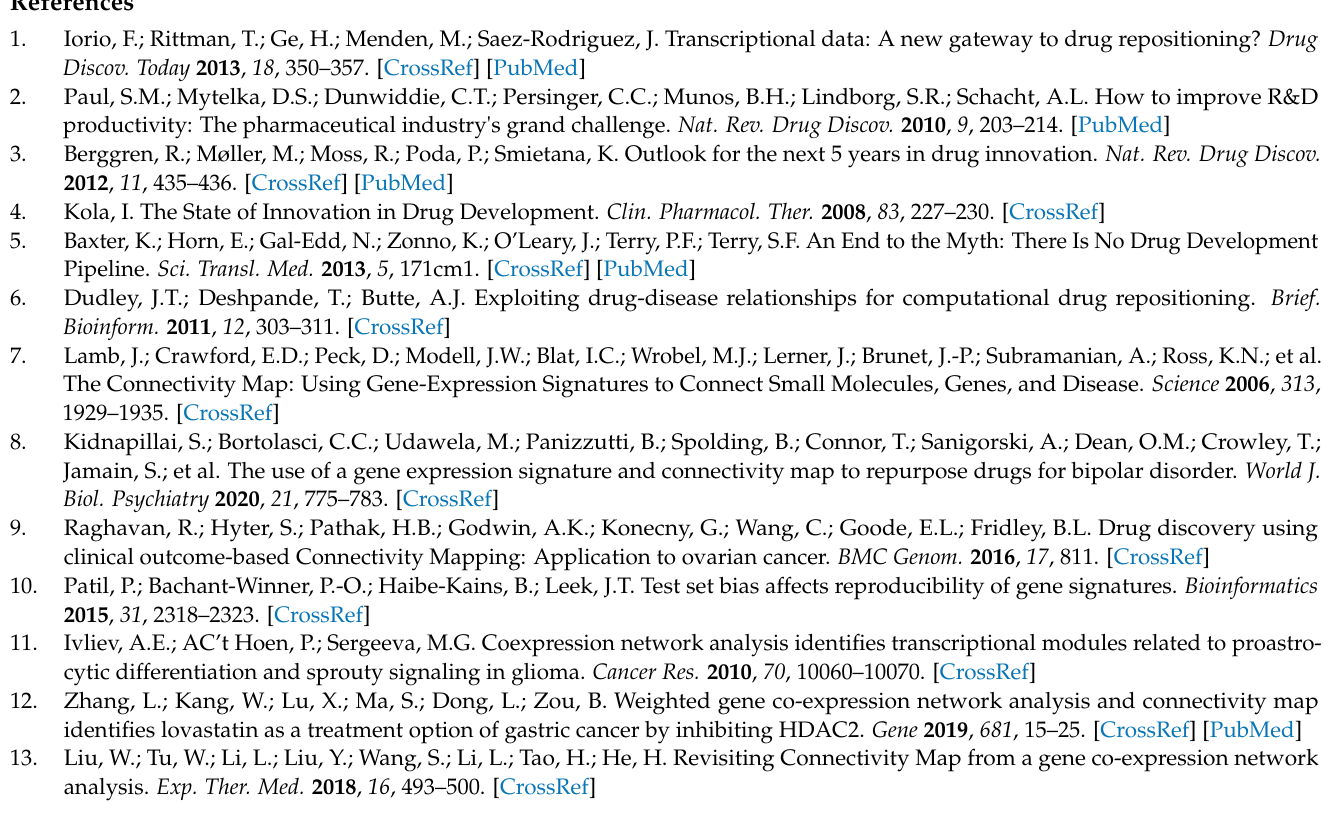
groups 7 and 26, Table S4: Biological function enrichment analysis results of up-regulated genes in group 26, Table S5: Biological function enrichment analysis results of down-regulated genes in group 7, Table S6: Biological function enrichment analysis results of up-regulated genes in group 7, Table S7: Biological function enrichment analysis results of down-regulated genes in group 7, Table S8: The grouping results of anti-JEV agents and the structural similarity of the anti-JEV